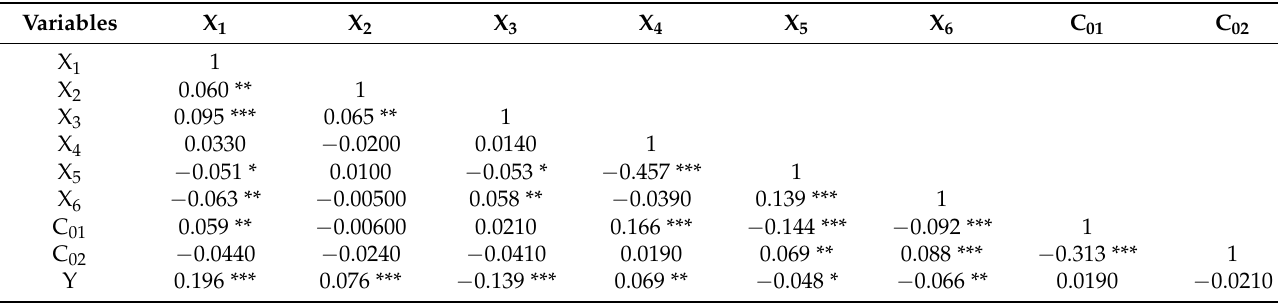
Table 6. Pearson correlations of variables.